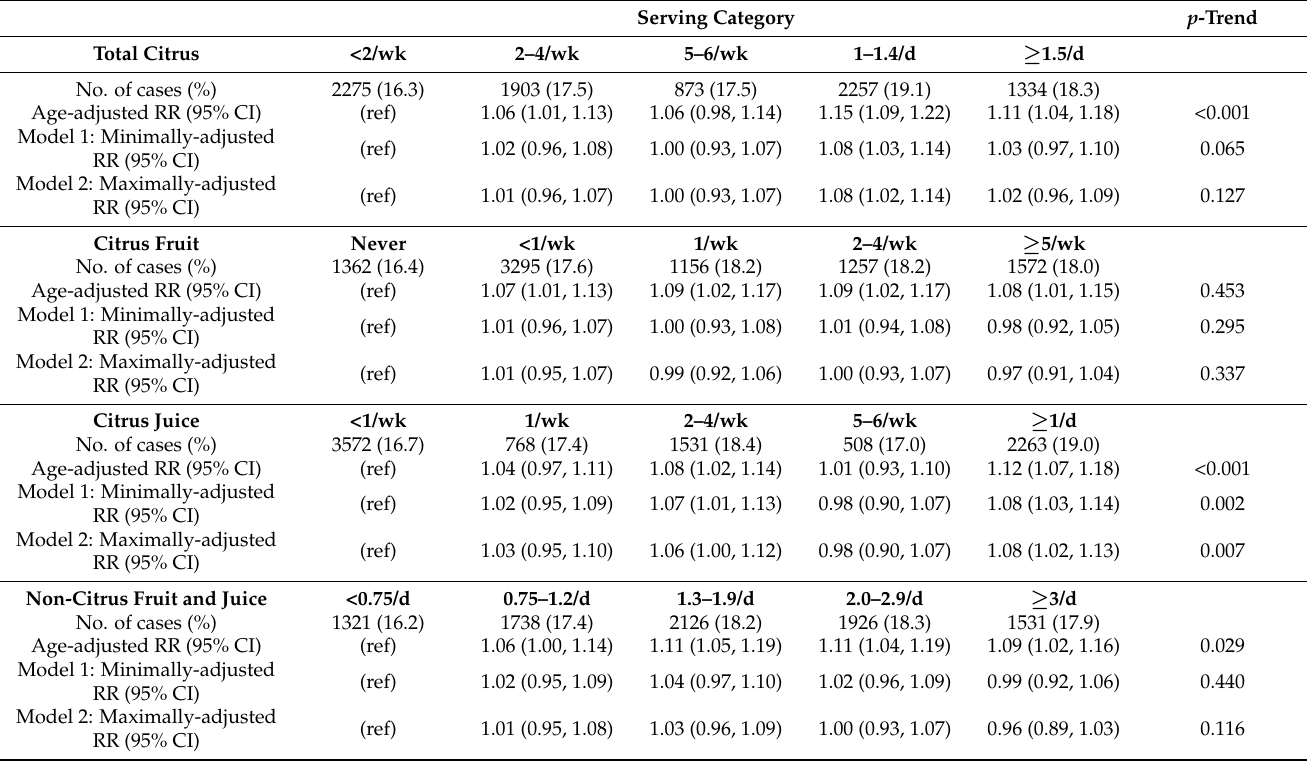
Table 2. The relative risk for incident non-melanoma skin cancer according to the frequency of citrus consumption among Women’s Health Initiative participants ( n =